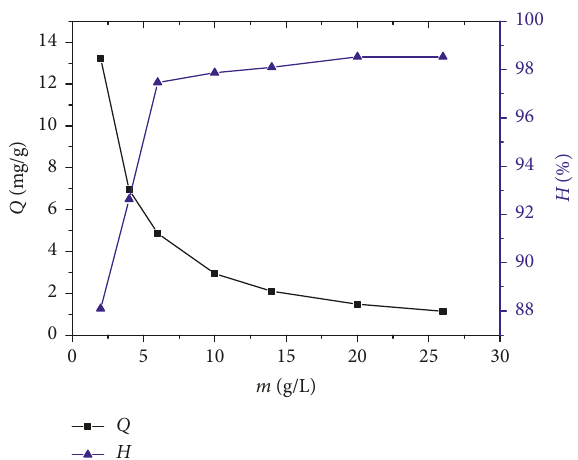
Figure 9: The variation of Pb 2+ adsorption capacity and removal efficiency according to contact time (m HApgranules C 0 30mg/L; pH 0 5.5; T (cid:31)